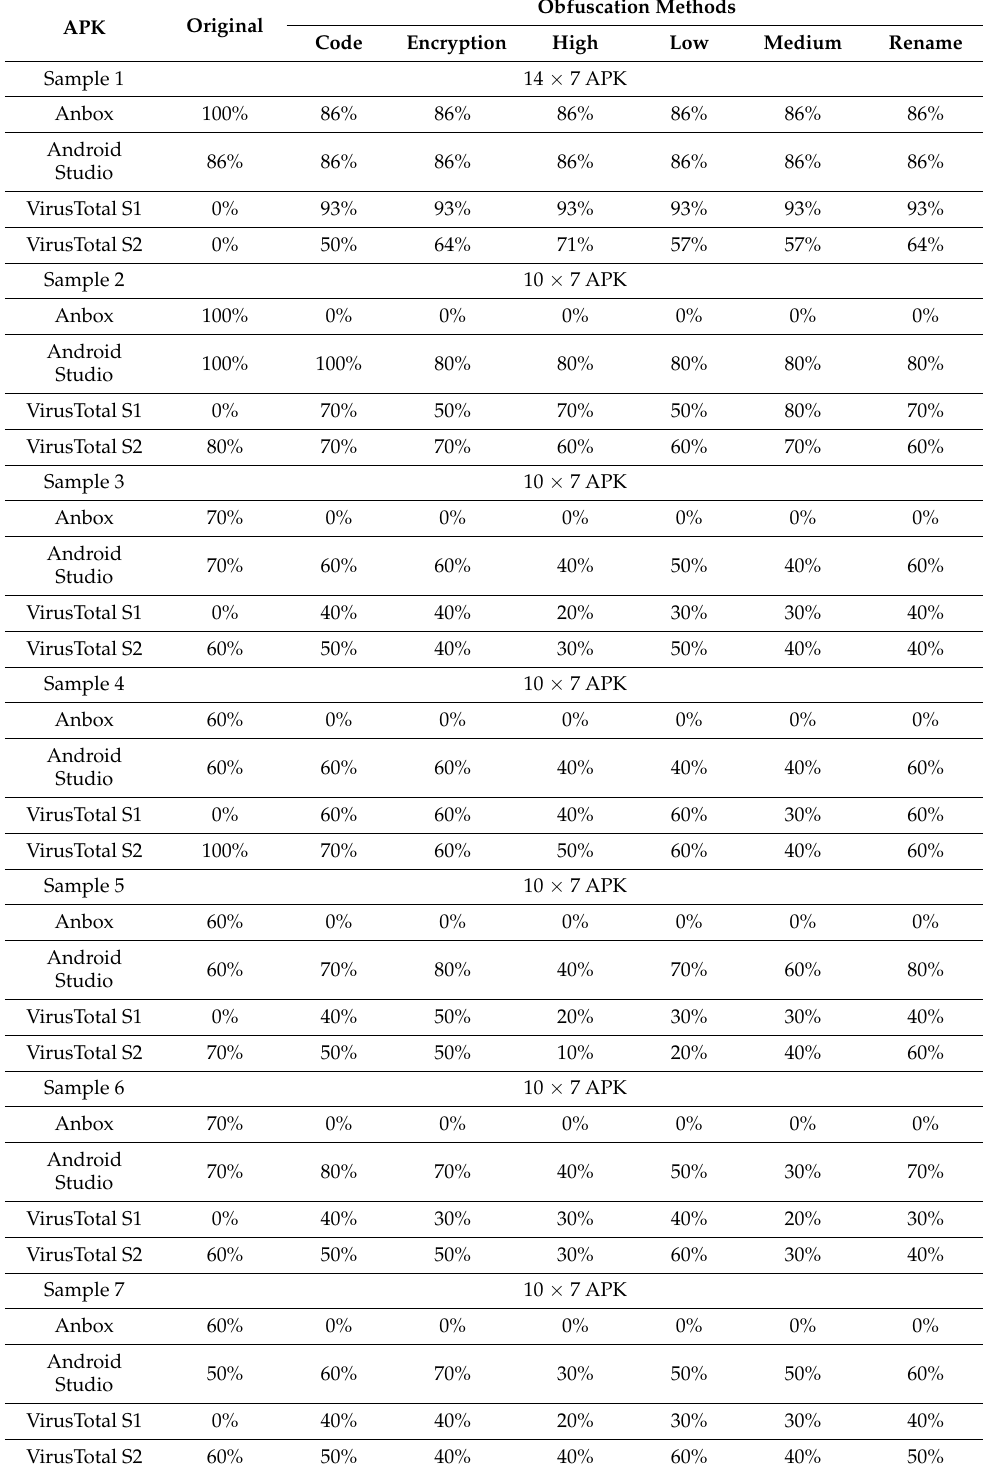
Table 12. Installability of Obfuscated